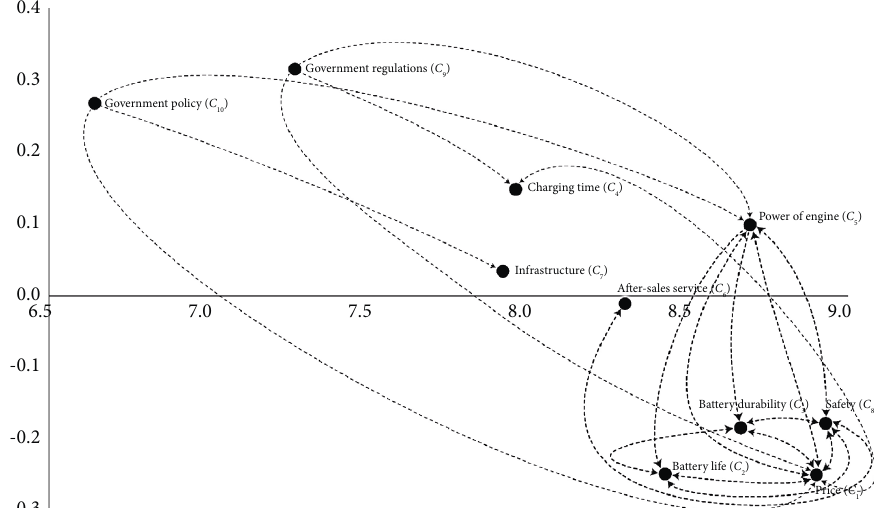
Figure 1: INRM of purchase intention factors of electric